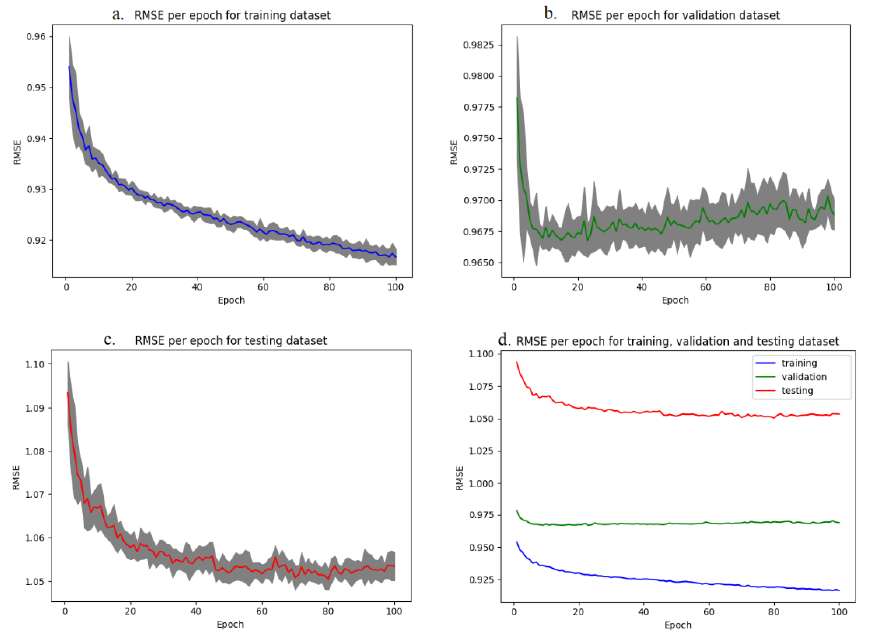
Figure 3. Metrics of the prediction model expressed in RMSE with s.d. for ( a ) training dataset, ( b ) validation dataset, ( c ) testing, and ( d ) training dataset, validation dataset, and testing under the same scale (without s.d.).